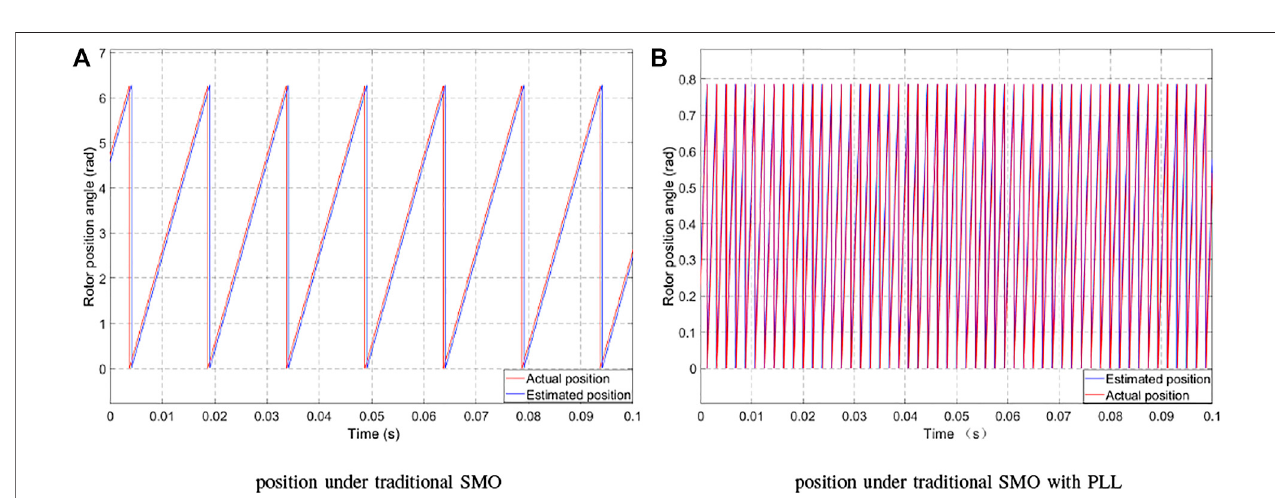
FIGURE 9 | Curve between the estimated and actual positions. (A) Position under traditional SMO. (B) Position under traditional SMO with PLL.